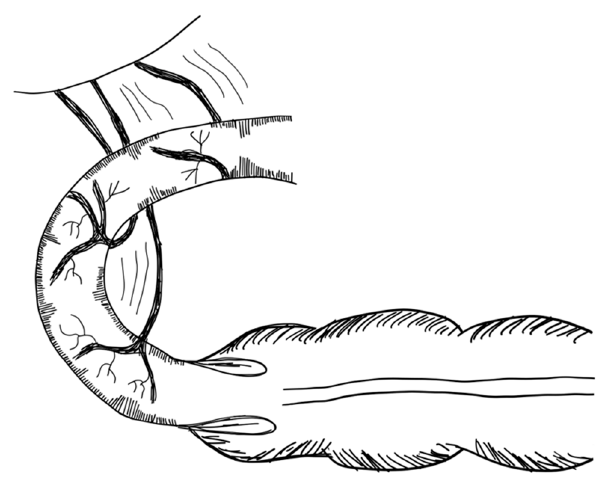
Figure 13. Nipple valve reconstruction. Shafiekhani et al. [169].